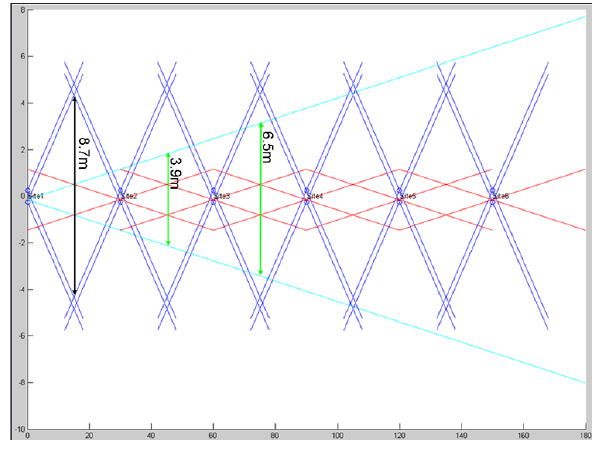
Figure 6. PanCam FOV analysis across multiple sites (assume the traverse segment is 30.7 m; X-Y axis have different scales)